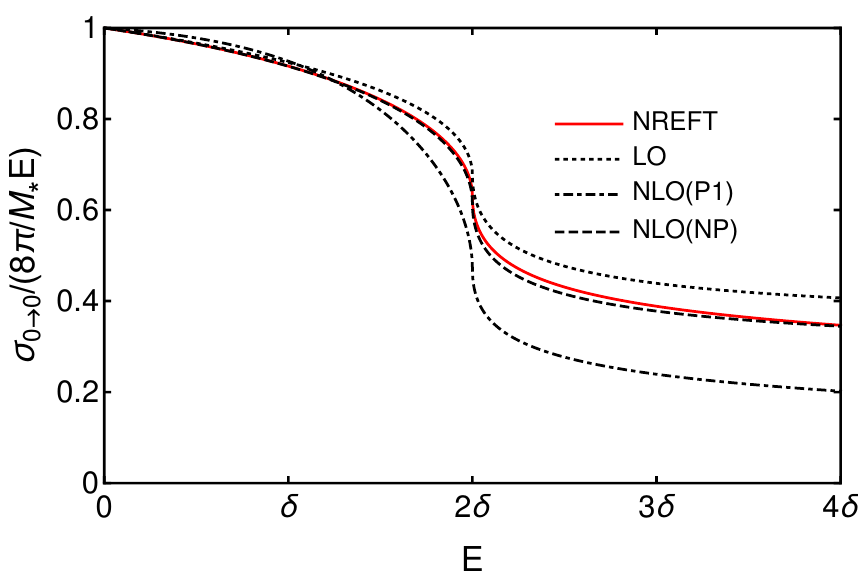
Figure 16 . The neutral-wino elastic cross section (cid:27) 0 ! 0 ( E ) divided by the S-wave unitarity bound as a function of the energy E . The cross section at the unitarity mass M (cid:3) = 2 : 88 TeV for (cid:14) = 170 MeV and (cid:11) = 0 is shown for NREFT (solid curve) and for ZREFT at LO (dotted curve), NLO(P1) (dot-dashed curve), and NLO(NP) (dashed